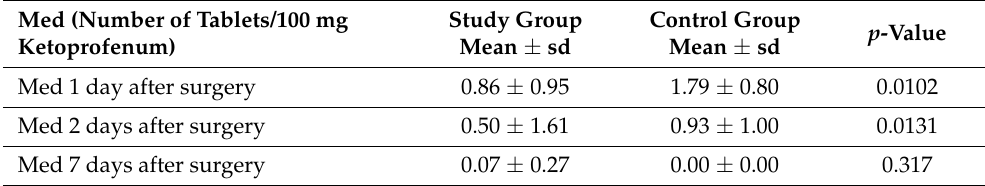
Table 6. Comparison of the use of NSAIDs (100 mg ketoprofenum) in the test group (n = 15) and the control group (n =